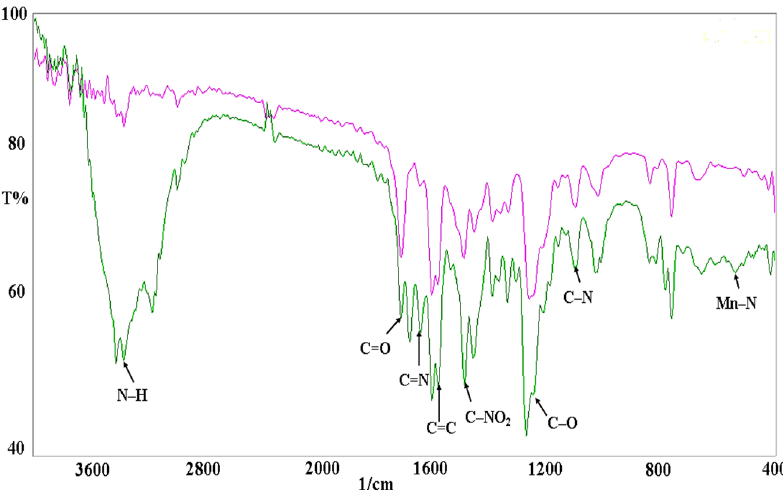
Figure 2. FT ‐ IR spectra of: (pink) the ligand (RCOOET) and (green) [(Cl) 2 Msdn(RCOOET)]. Figure 2. FT-IR spectra of: (pink) the ligand (RCOOET) and (green) [(Cl) 2 Msdn(RCOOET)].